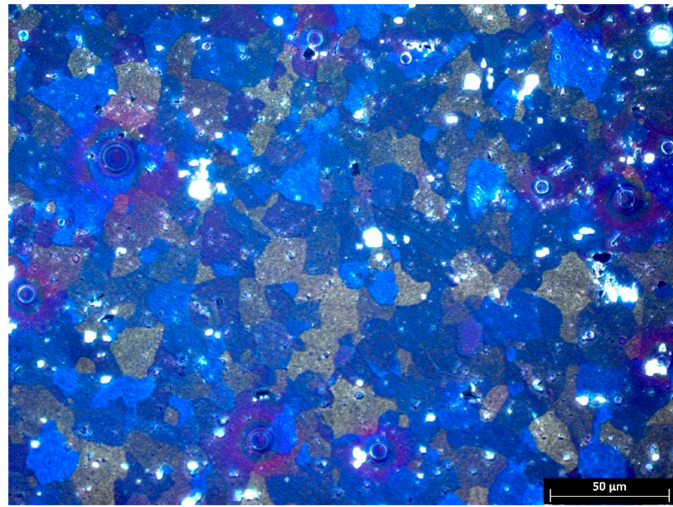
Figure 2. Microstructure of the 5754 aluminum alloy in an initial